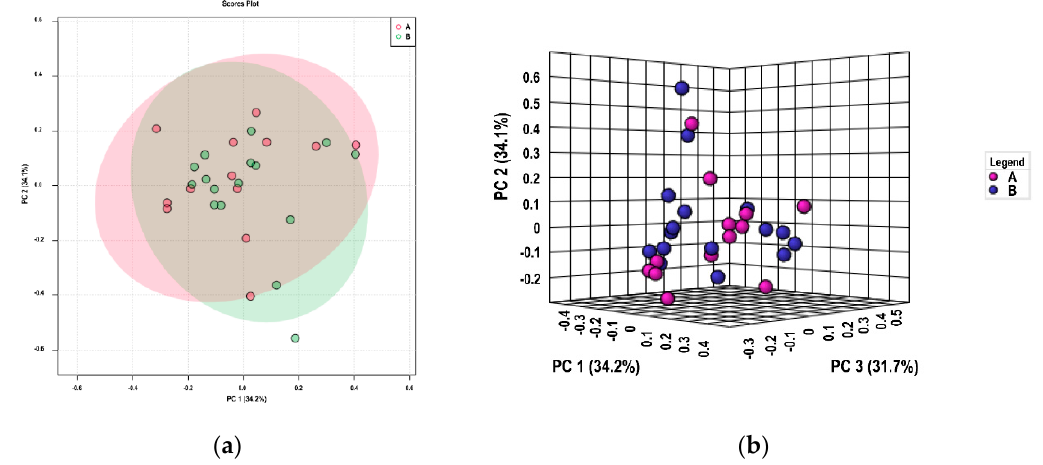
Figure 6. Population relationships of the collected L. kasmira individuals. ( a ) Principal component analysis (PCA) plot of 30 L. kasmira individuals based on all SNP loci between the ZB and MJ populations. A and B represent the MJ population and ZB population, respectively; ( b ) three − dimensional PCA clustering map of 30 L. kasmira individuals based on all SNP loci between the ZB and MJ populations. A and B represent the MJ population and ZB population, respectively.